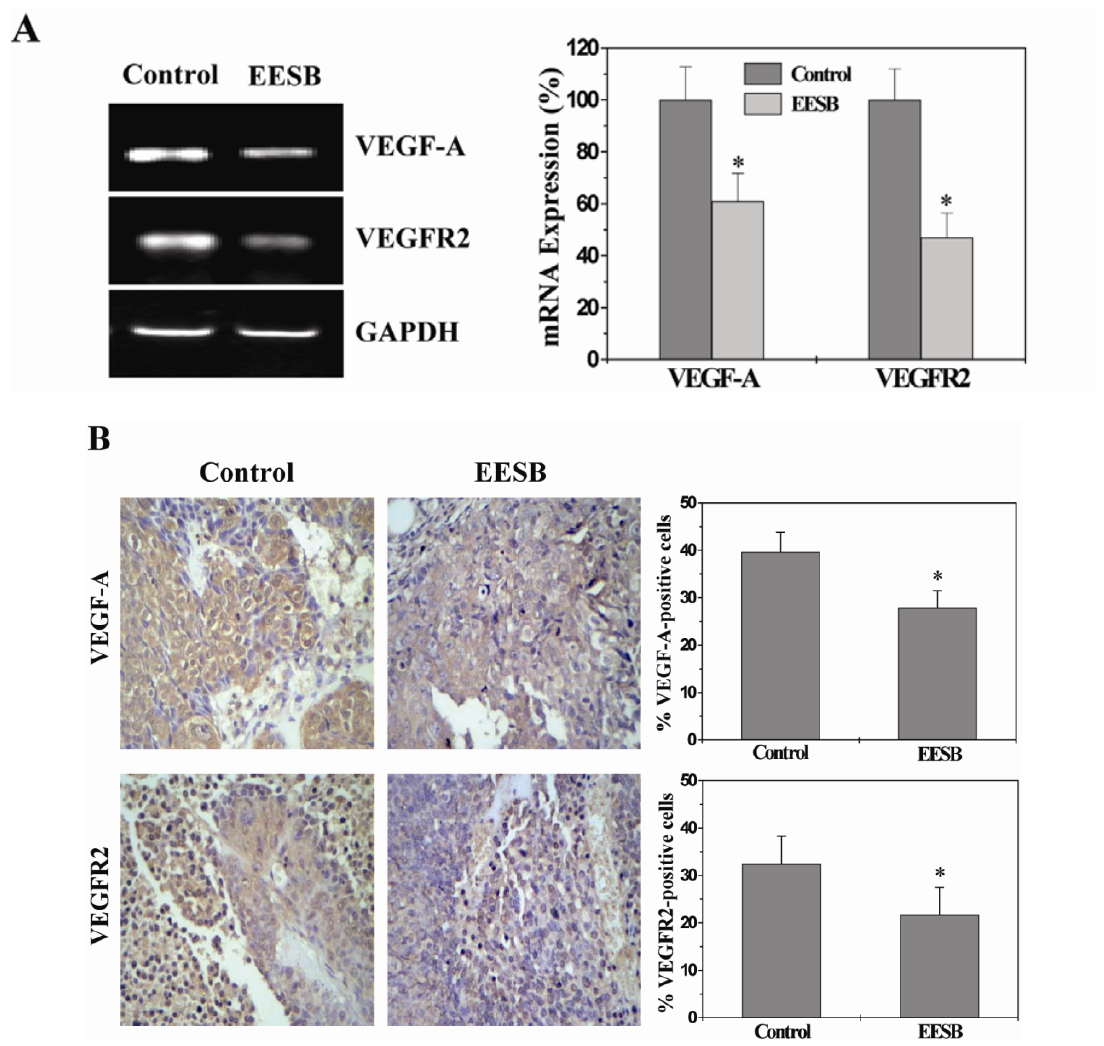
Figure 4. Effect of EESB on the expression of VEGF-A and VEGFR2 in CRC xenograft mice. ( A ) The mRNA expression levels of Vascular endothelial growth factor-A (VEGF-A) and VEGF Receptor 2 (VEGFR2) were determined by RT-PCR. GAPDH was used as the internal control. The data of densitometric analysis were normalized to the mean mRNA expression of untreated control (100%); ( B ) Tumor tissues were processed for IHC staining for VEGF-A and VEGFR2. The photographs were representative images taken at a magnification of ×400. Quantification of IHC assay was represented as percentage of positively-stained cells. Data shown were averages with S.D. (error bars) from 10 individual mice in each group. * p < 0.05, versus